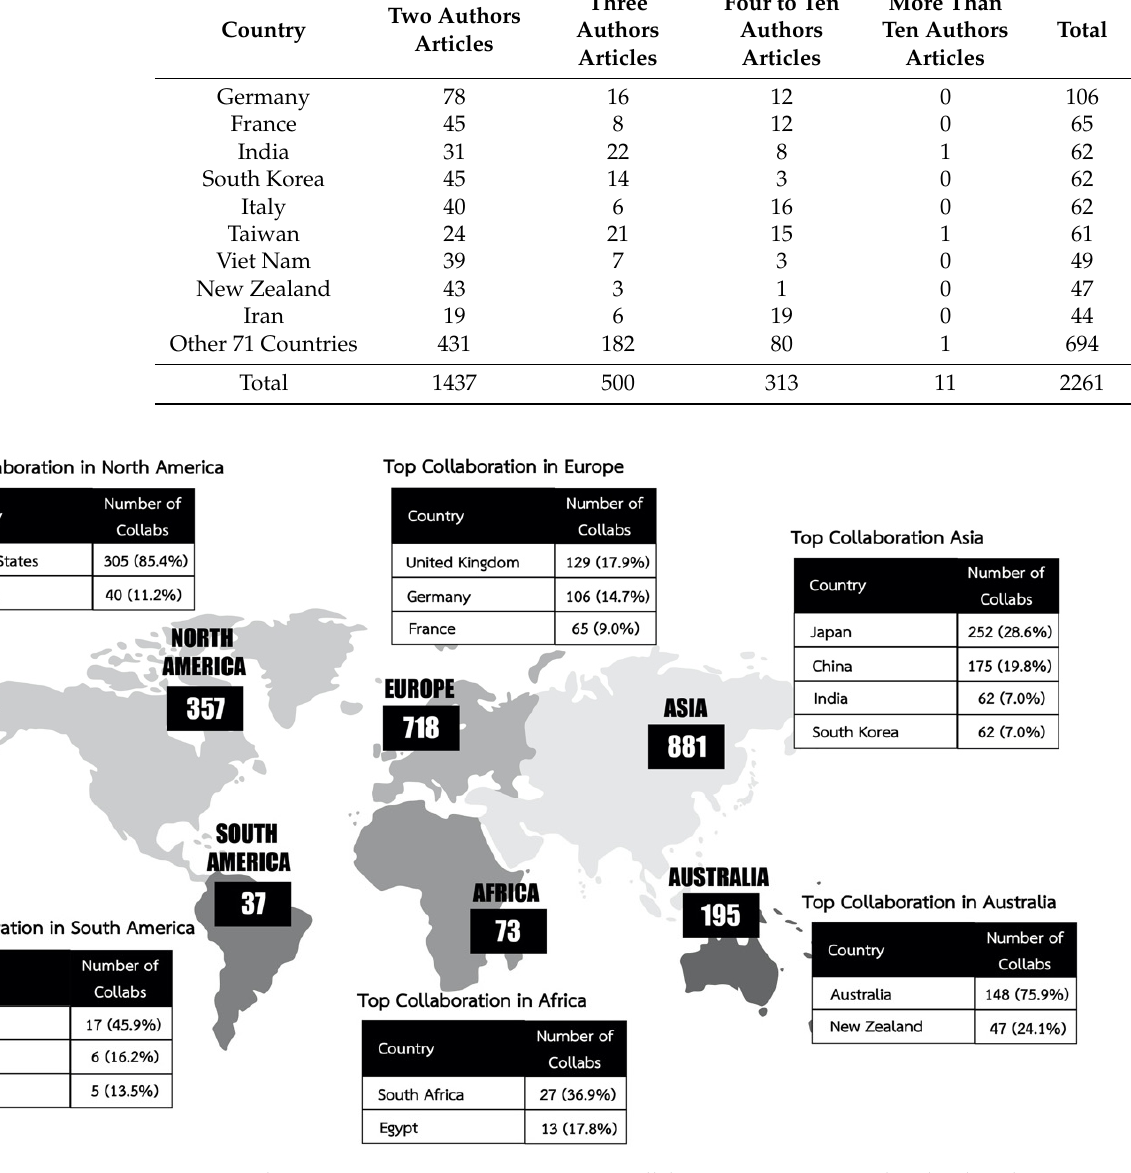
Figure 1. Chiang Mai university’s cross-country collaboration in science and Technology by continent.